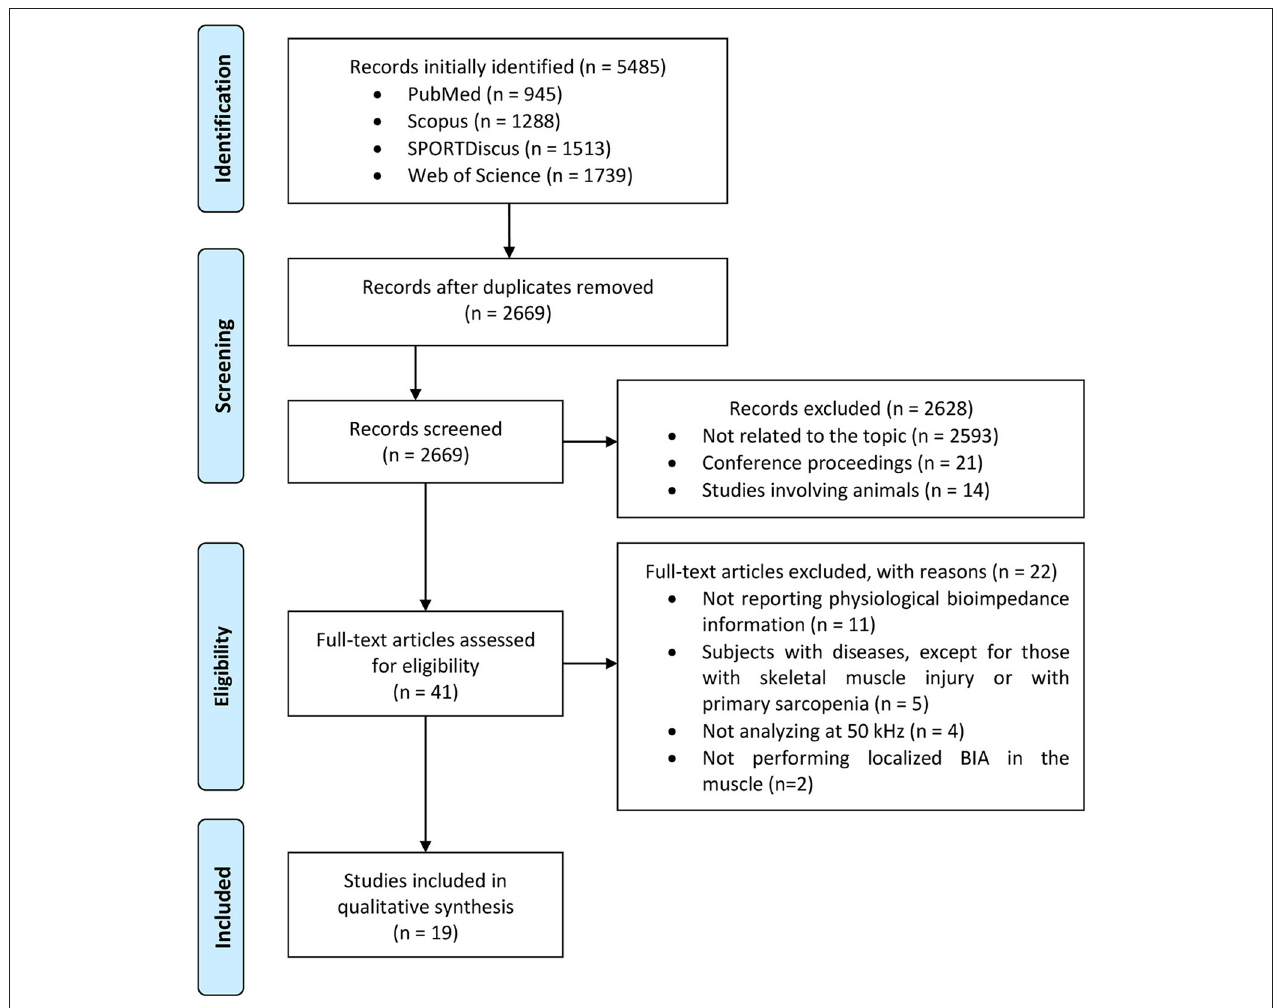
FIGURE 1 | Flow chart of study identification and eligibility for the systematic